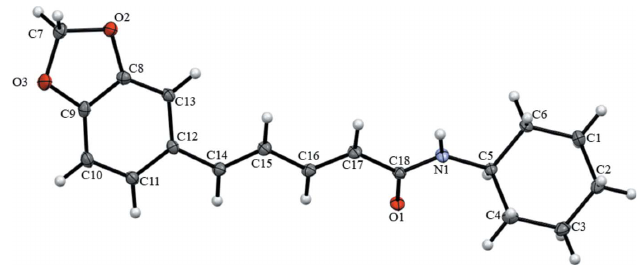
Figure 2 Displacement ellipsoid drawing at a 50% probability level of the asymmetric unit of (I).